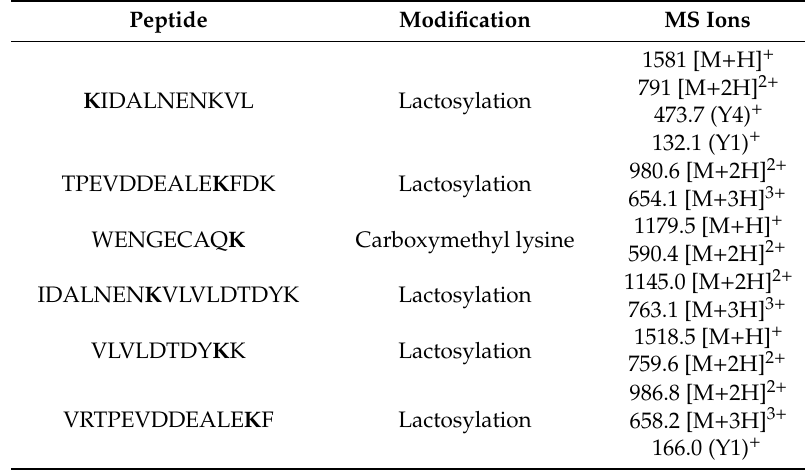
Table 4. Identified modified peptides deriving from β -lactoglobulin in the chymotryptic and tryptic digestions (in bold is highlighted the modified residue).